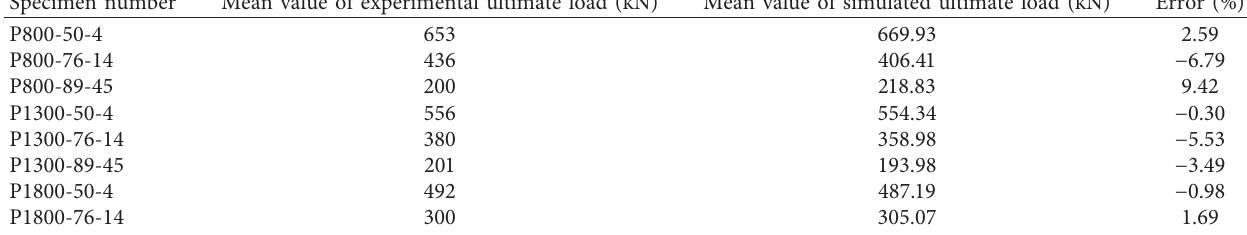
j curves of different sections. (b) Slope of transverse strain